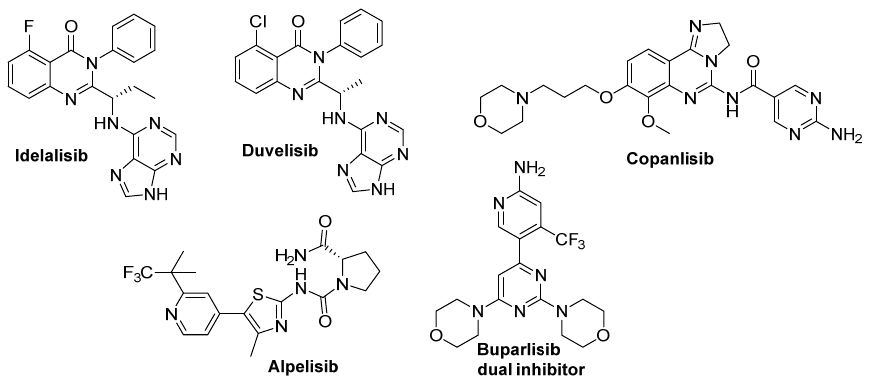
Figure 1. Approved FDA PI3K inhibitors and PI3K/mTOR dual inhibitors in phase III clinical tri- als.